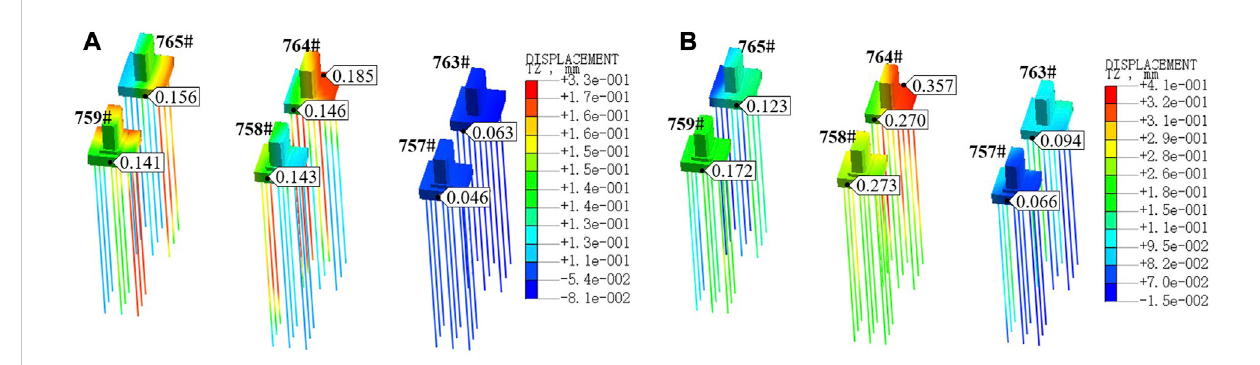
FIGURE 8 Vertical displacement of the piers (with isolation piles) (A) right line through, (B) left line through.